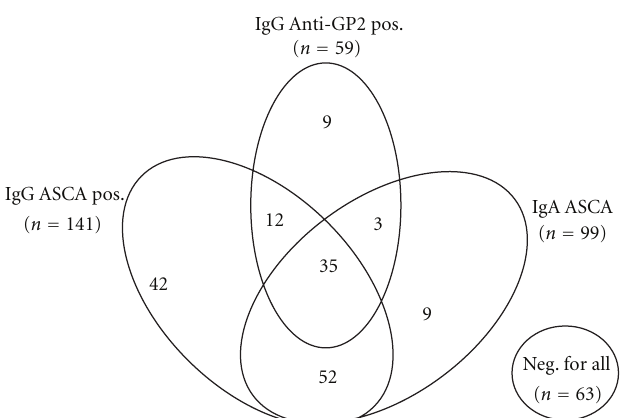
Figure 3: Venn Diagram showing IgA ASCA, IgG ASCA, and IgG anti-GP2 antibody reactivity of the 225 Crohn’s disease (CD) patients.